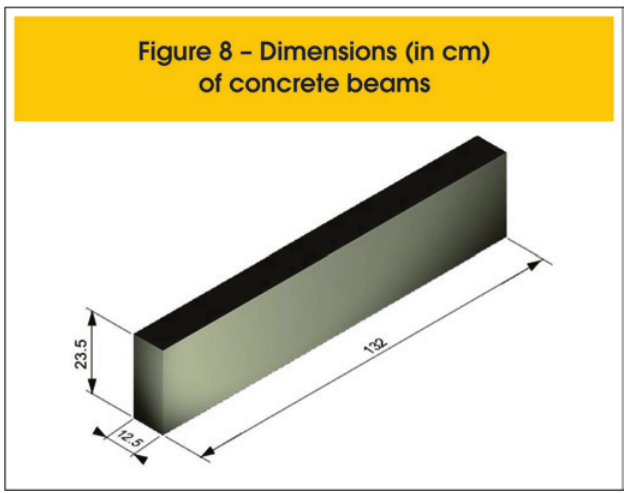
Figure 10 corresponds to the beam reinforcement employed in the four-point bending test and the positions of the strain-gauges relative to the measurements of the deformations in the longitudinal reinforce- ment (E3 position), transversal reinforcement (E1 and E2 positions), and compressed region (E4 position) of the concrete. The beams were designed to have insufficient transversal reinforcement, in order to induce shear rupture and increase the demand on the stirrups. The longitudinal reinforcement was composed by two steel bars of 12.5 mm diameter each (N1), whereas the transversal reinforce - ment consisted of eight stirrups made with 5-mm diameter steel (N3). Furthermore, two steel bars with 6.3 mm diameter were used as stirrups guide only (N2). The beam span was 120 cm, being the two loads equidistantly applied at 40 cm from the